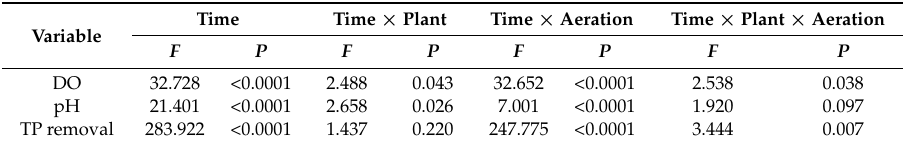
Table 1. Results of two-way repeated measures analysis of variance when Fe:P = 5. DO, dissolved oxygen; TP, total phosphorus.